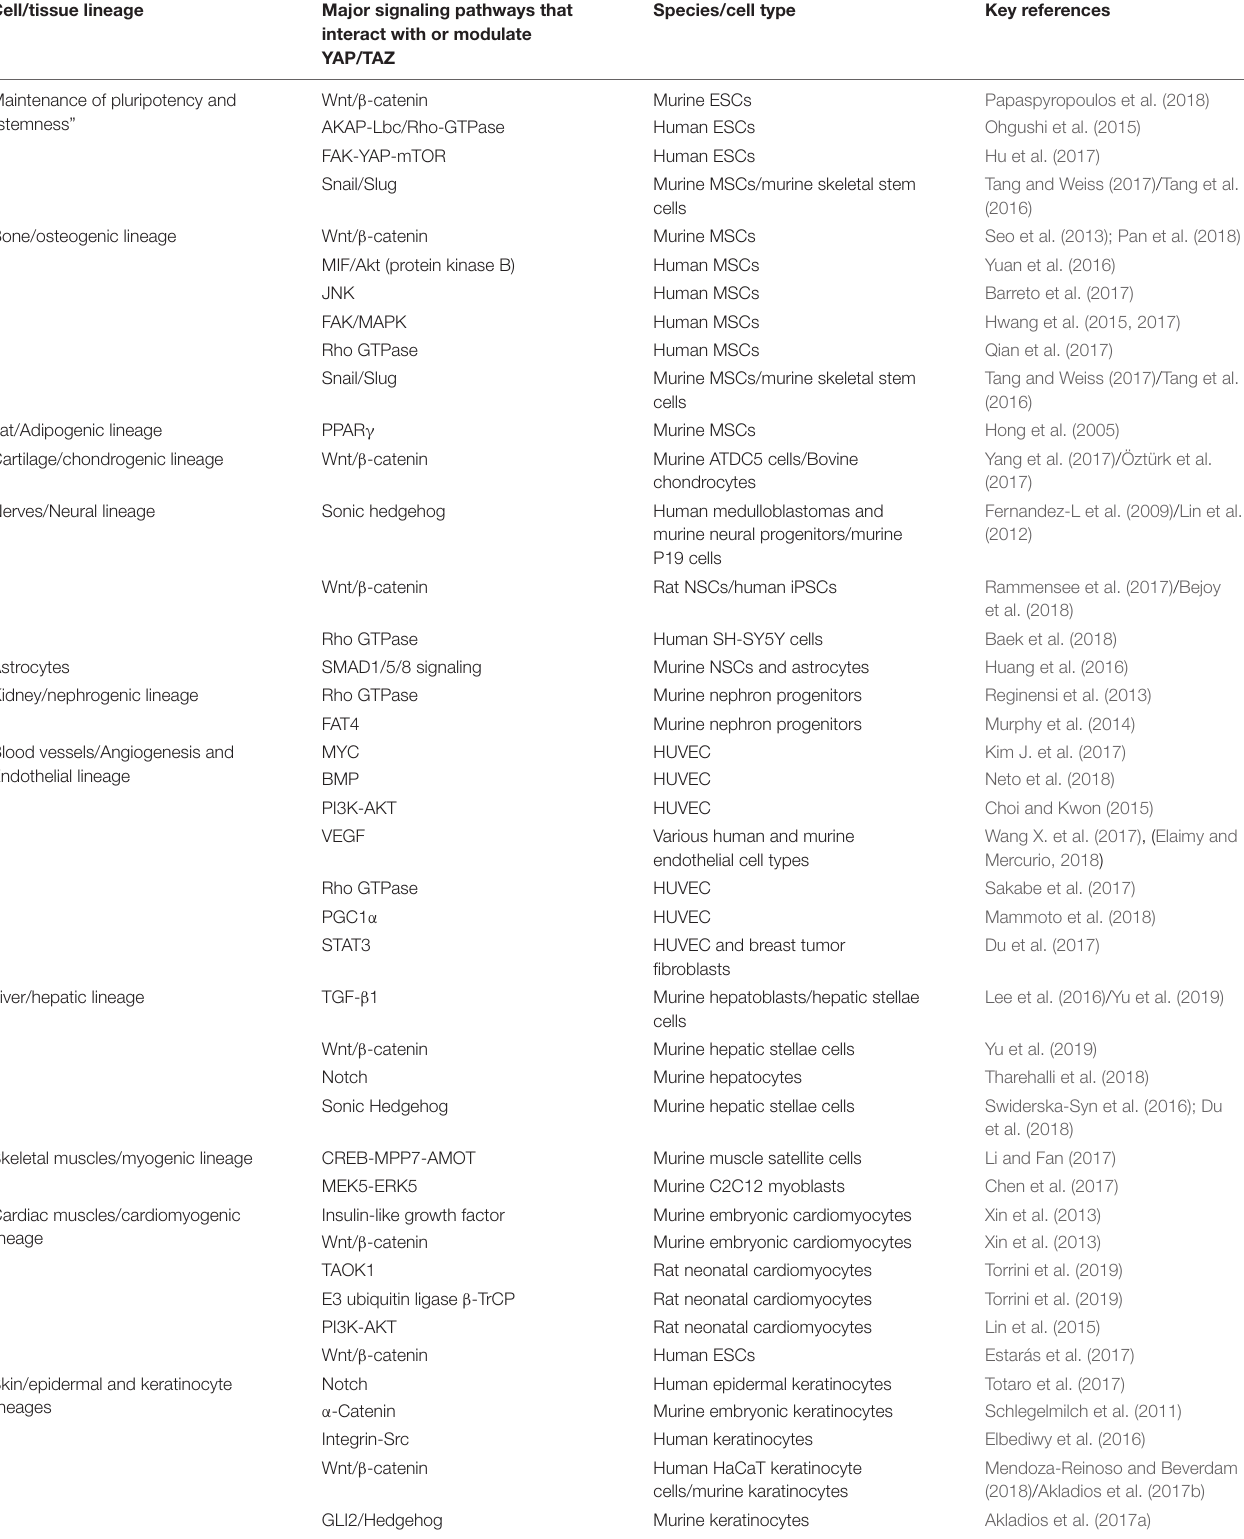
TABLE 1 | Major signaling pathways that interact with or modulate YAP/TAZ in various cell and tissue lineages, which in turn effect cell fate decisions such as proliferation, differentiation, and maintenance of